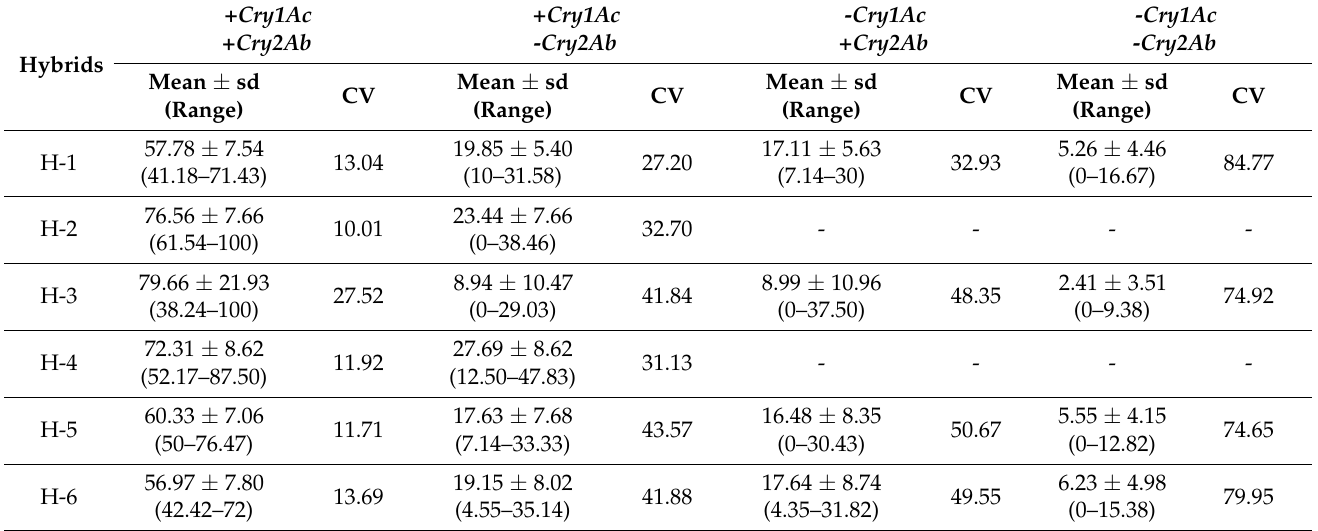
Table 1. Expression of the Cry genes in the seeds produced by Bt cotton hybrids. The values represent percentage of seeds in a